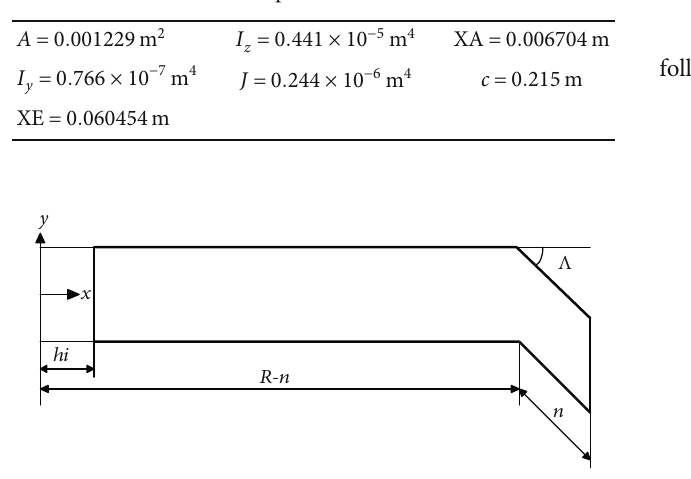
Figure 7: Blade planform with tip sweep ( Λ = 45 ° ).